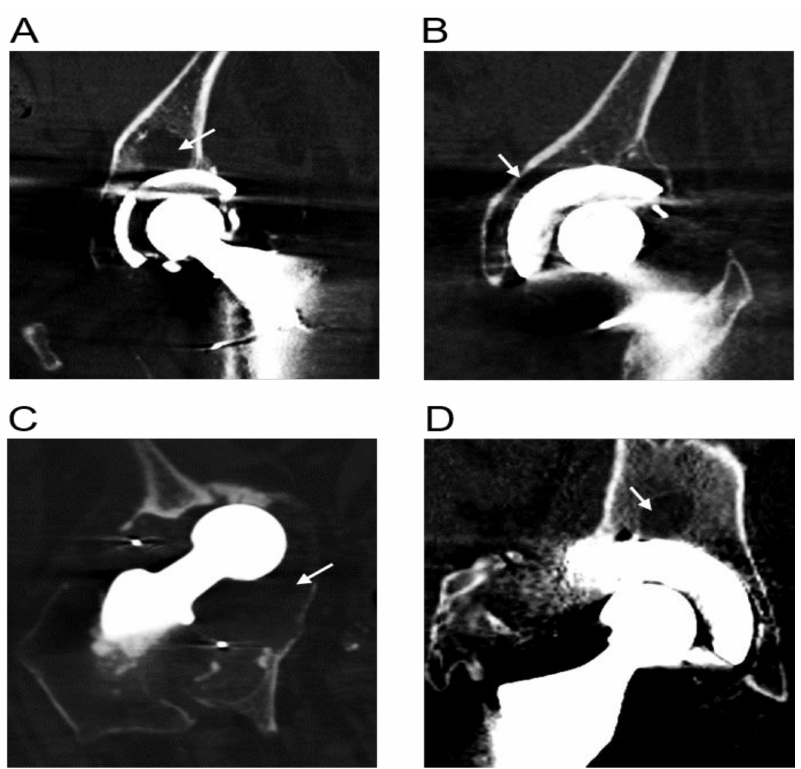
Figure 1. Representative radiographs of four revision patients with osteolytic lesions (white arrows). Corresponding patient and implant details are listed in Table 2 and are as follows: ( A ) Patient 1, ( B ) Patient 2, ( C ) Patient 8 and ( D ) Patient